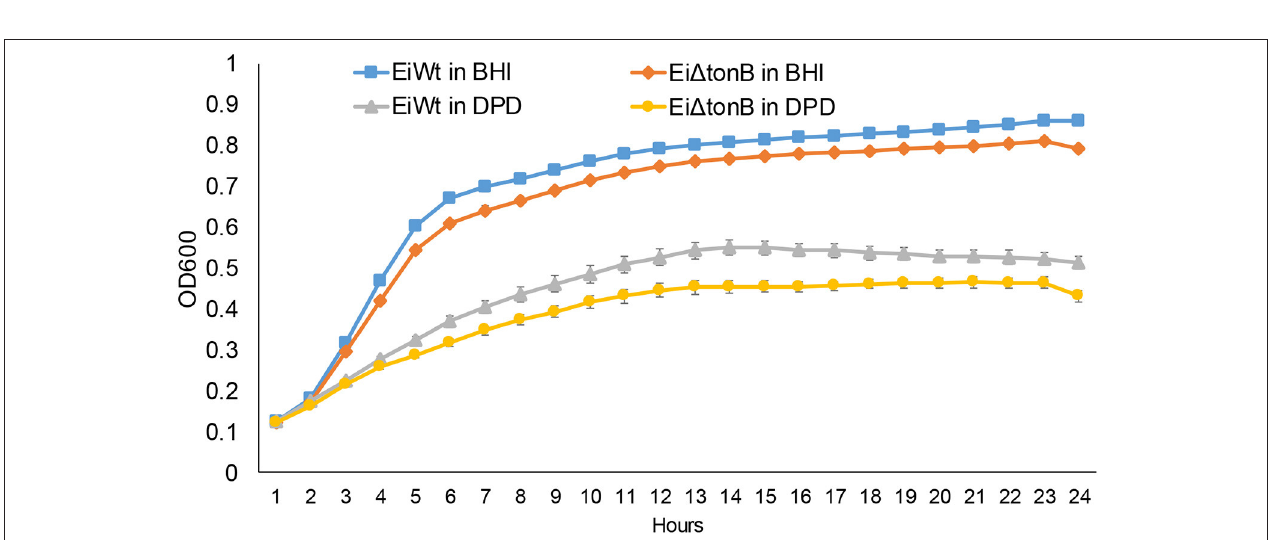
FIGURE 3 | Growth of Ei 1 tonB and 93–146 in BHI broth and BHI broth supplemented with 100 µ M 2 ′ 2-dipyridyl (DPD). These data represent the mean ± SE of 12 replicates from two experiments. Standard error bars are